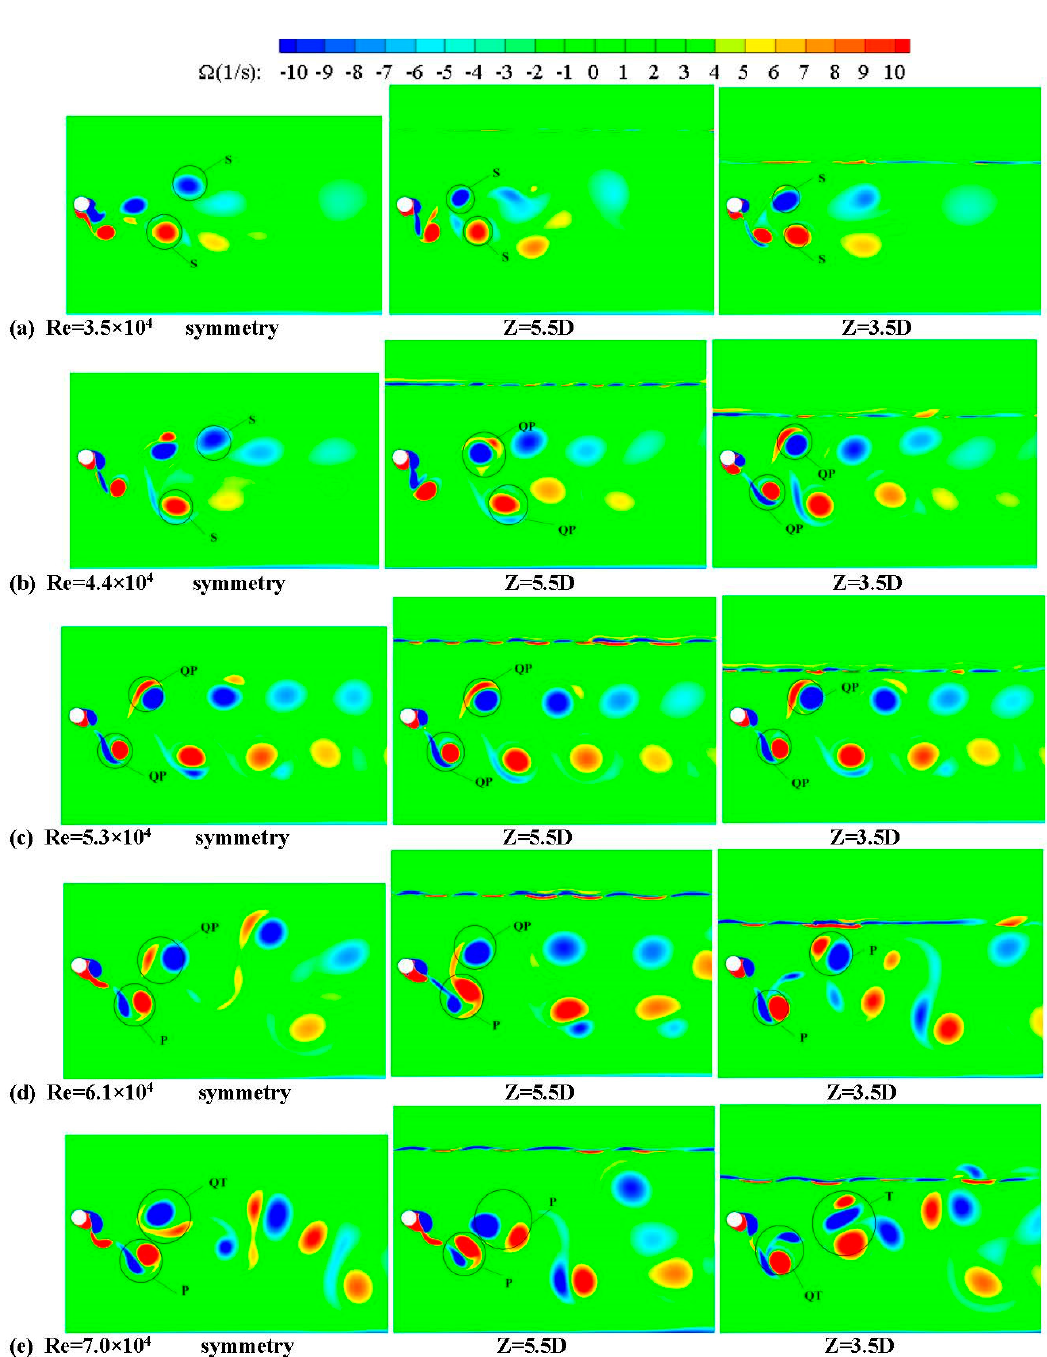
Figure 13. The vortex structure of the flow-induced vibration of the PTC cylinder in the free surface flow.